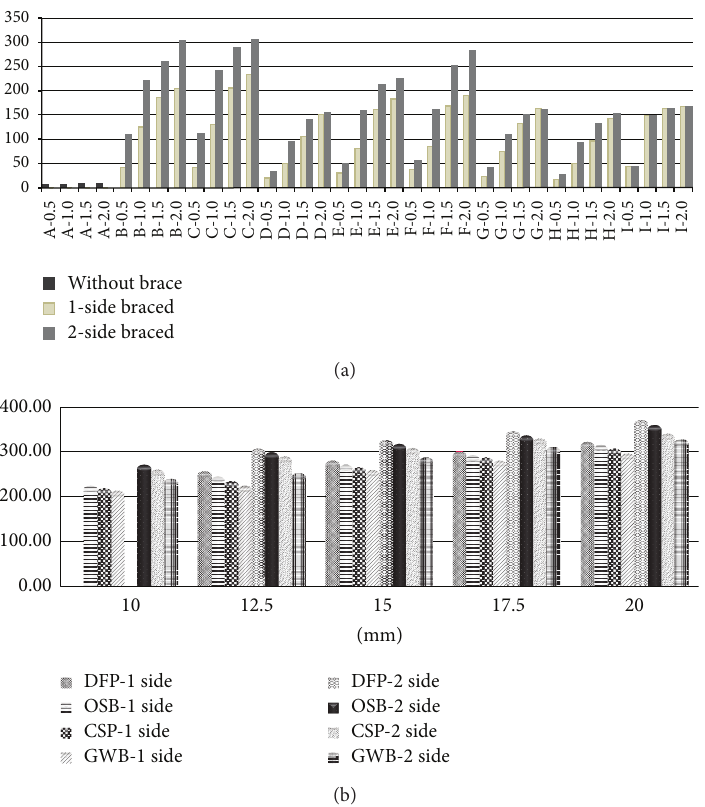
Figure 14: Maximum strength of the specimens (kN). (a) Braced walls. (b) Sheeting